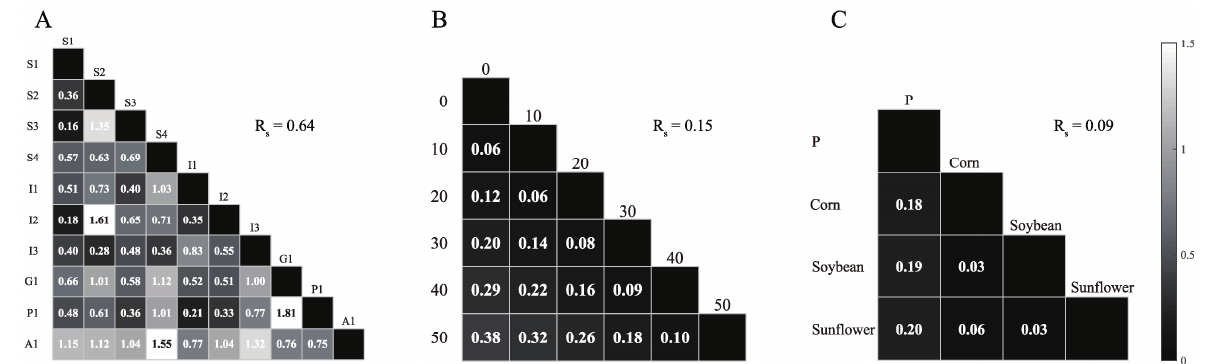
Figure 3. Projected difference resolution (PDR) mapping of conventional PDR results. ( A ) EVOO Origin; ( B ) Adulteration Level; ( C ) Adulterant Type. R s , geometric average of all PDR scores. P, pure samples.